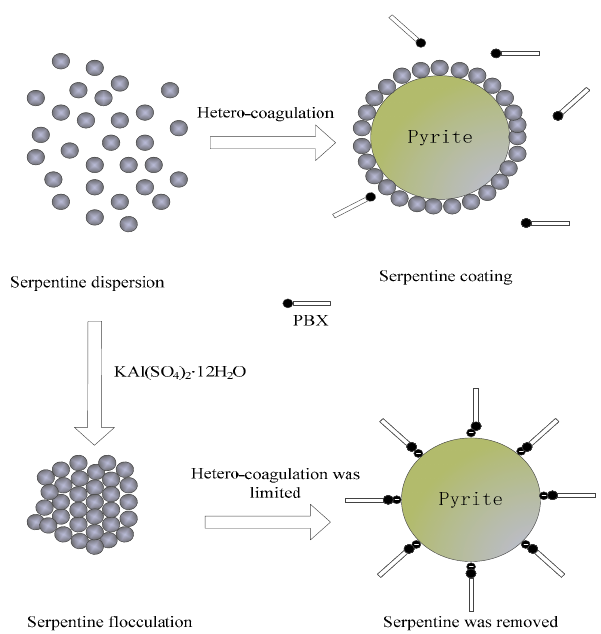
Figure 9. Schematic illustration of the effect of KAl(SO 4 ) 2 · 12H 2 O on the flotation of pyrite in the presence of serpentine.